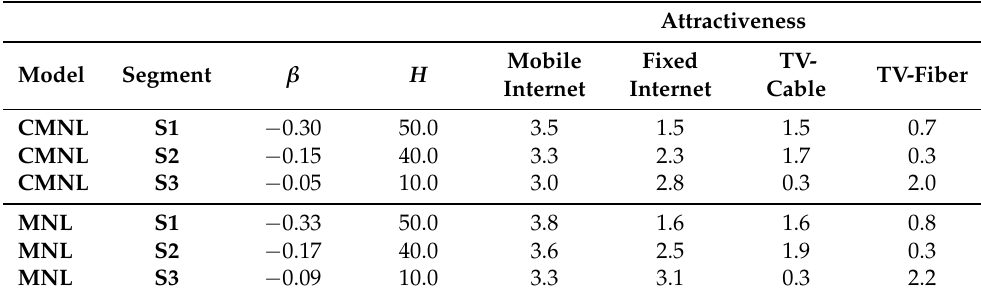
Table 11. Segment size H , price sensitivities β and services